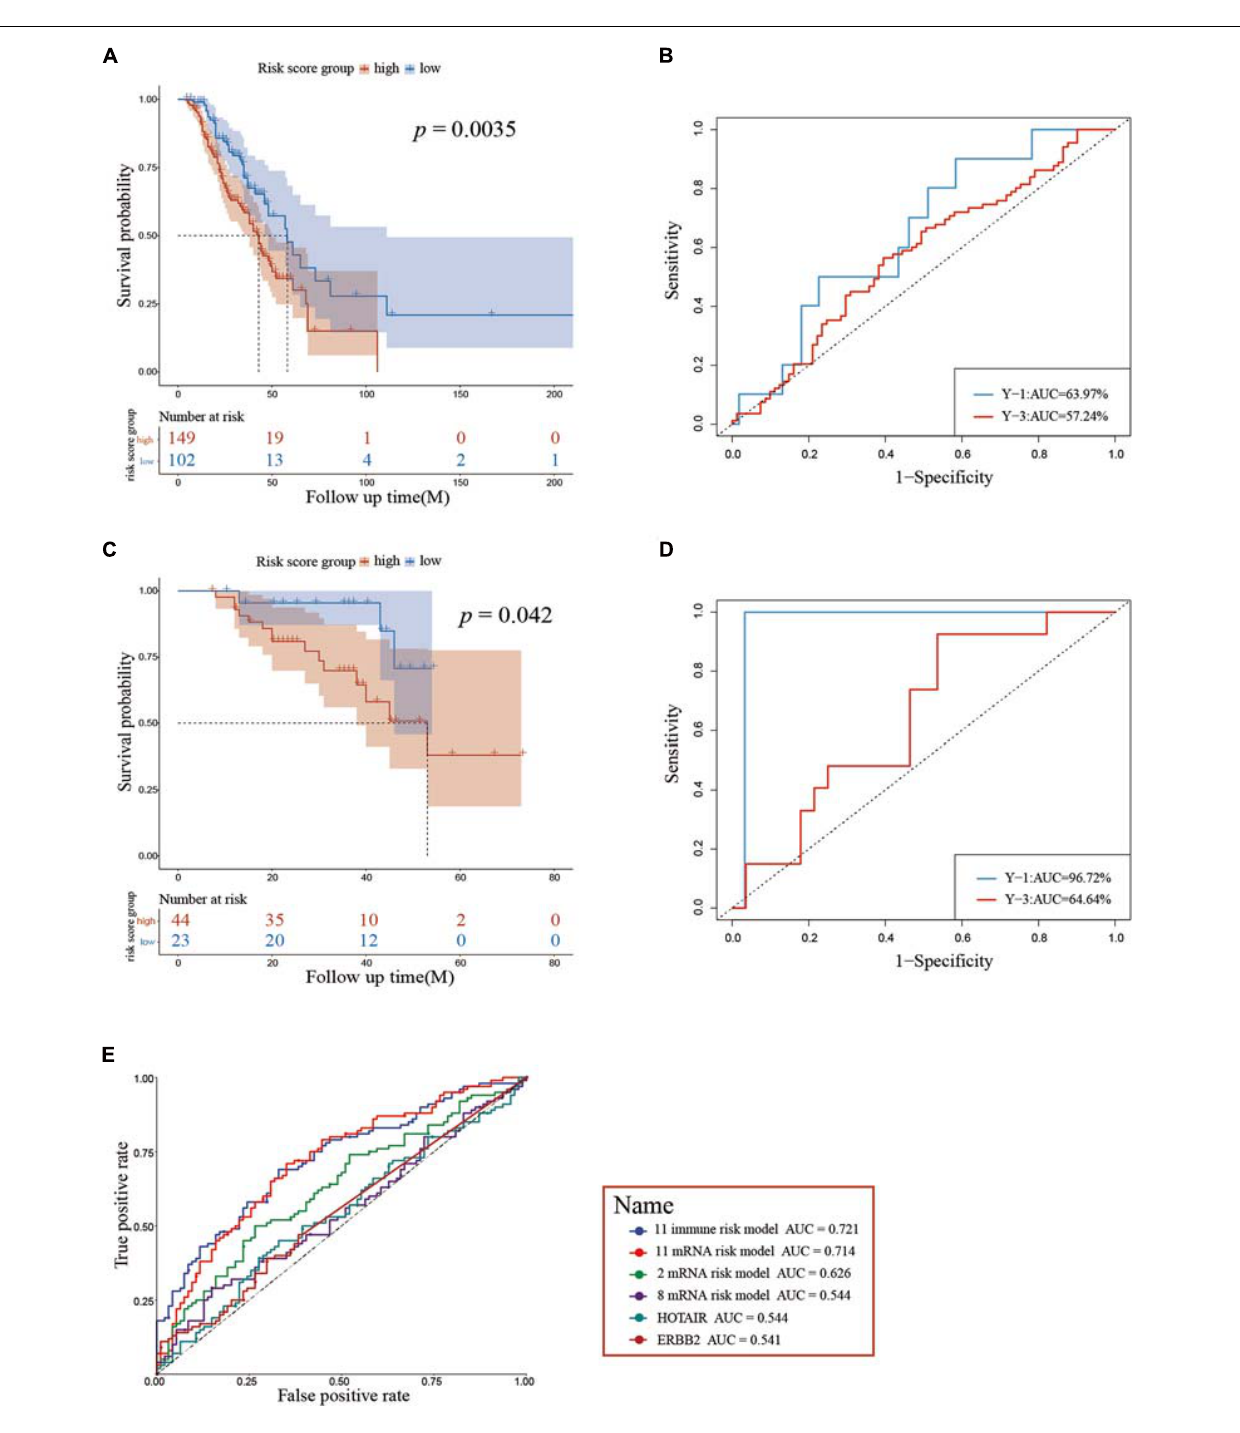
FIGURE 6 | Assessment of prognostic capacity using the two external cohorts GSE9891 (A,B) and GSE14764 (C,D) , respectively. (E) ROC curves show the sensitivity and specificity of the immune risk model signature and other known biomarkers in predicting the OS of patients. ROC, receiver operating characteristic; AUC, area under the